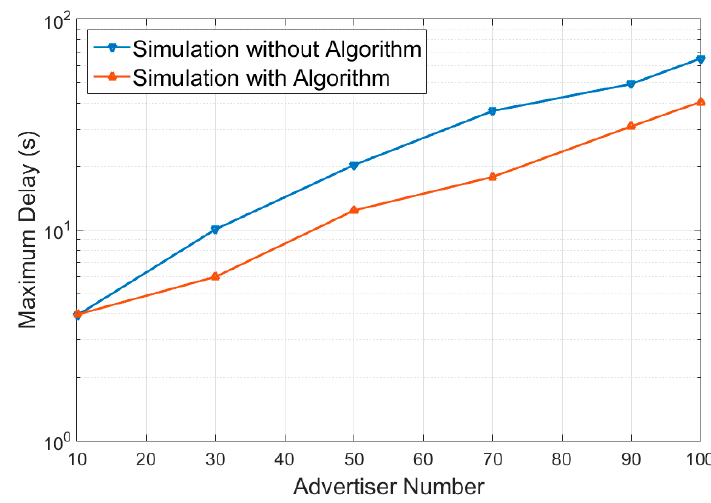
Figure 15. Maximum delay of one advertiser discovery by the initiator in the worst-case scenario.